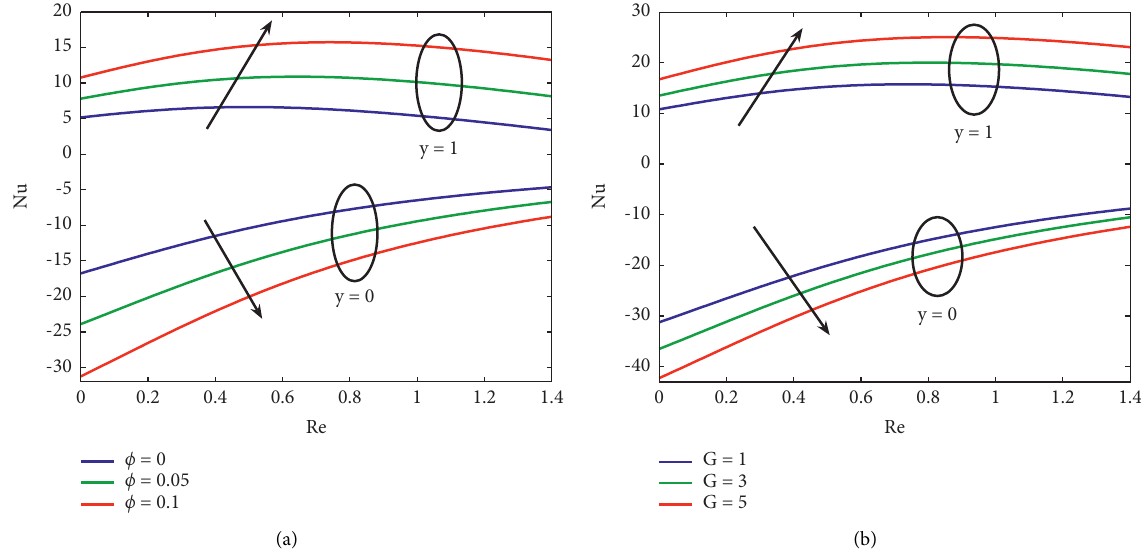
Figure 12: (a) Effect of φ on “Nusselt number distribution” when G � 1 , Ec � 1 , Ha � 0 . 5 , Rd � 2 , and Pr � 21. (b) Effect of G on “Nusselt number distribution” for φ � 0 . 1, Ec � 1, Ha � 0.5, Rd � 2, and Pr �